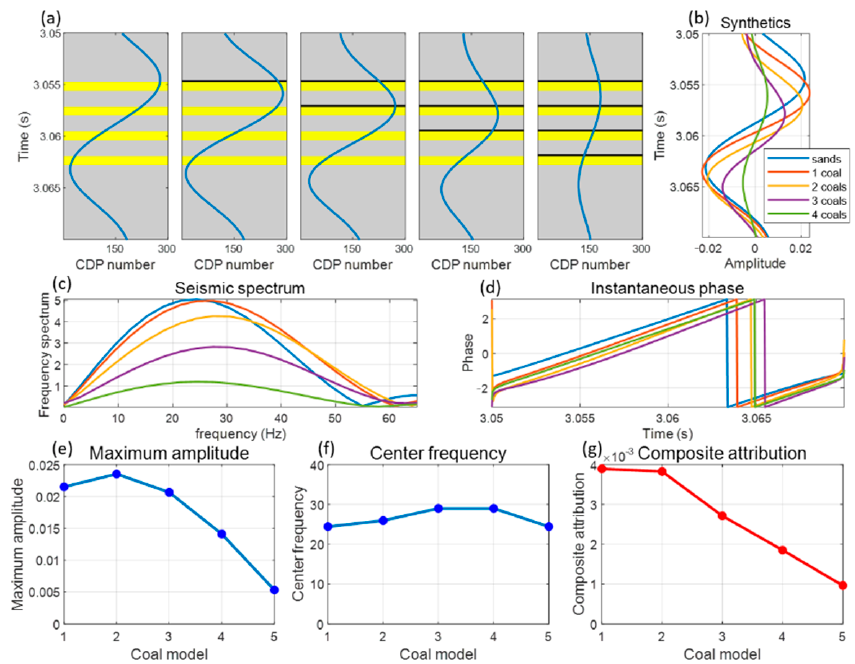
Figure 8. Model of thin coal seams coupled with sandstone and its synthetics and attributes: ( a ) coal model, ( b ) synthetic, ( c ) seismic frequency spectrum, ( d ) instantaneous phase, ( e ) maximum ampli- tude, ( f ) centre frequency, and ( g ) composite attribute.